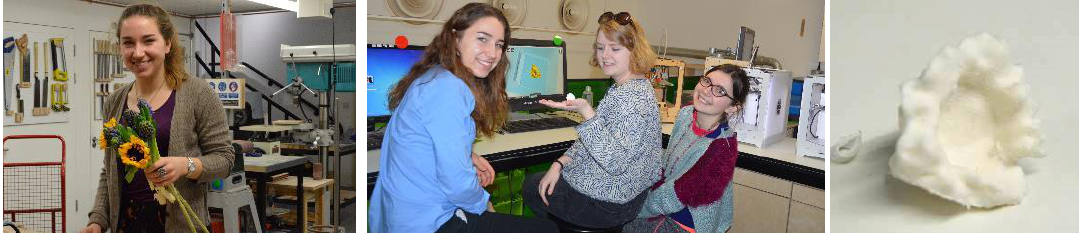
Figure 1. Students during 3D imaging (left) and 3D printing (middle and right) at the Institute of Making in 2015. The project addressed objects in zoological collections and the need to create models for teaching of ephemeral specimens, here